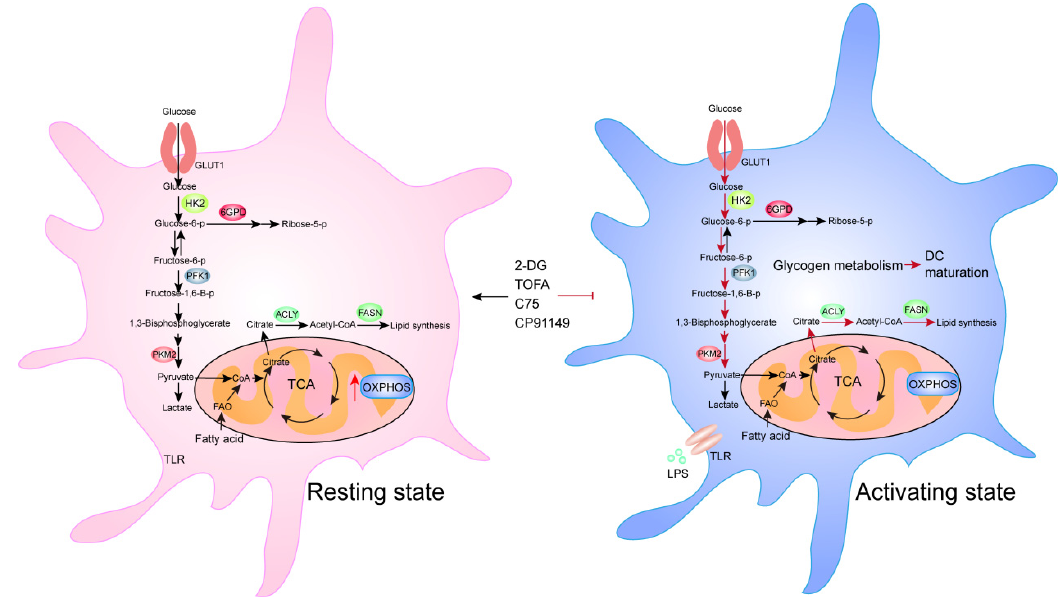
Figure 4. Overview of cellular metabolic plasticity in DCs. The red arrows indicate enhanced metabolic pathways, whereas the black arrows indicate baseline activities.